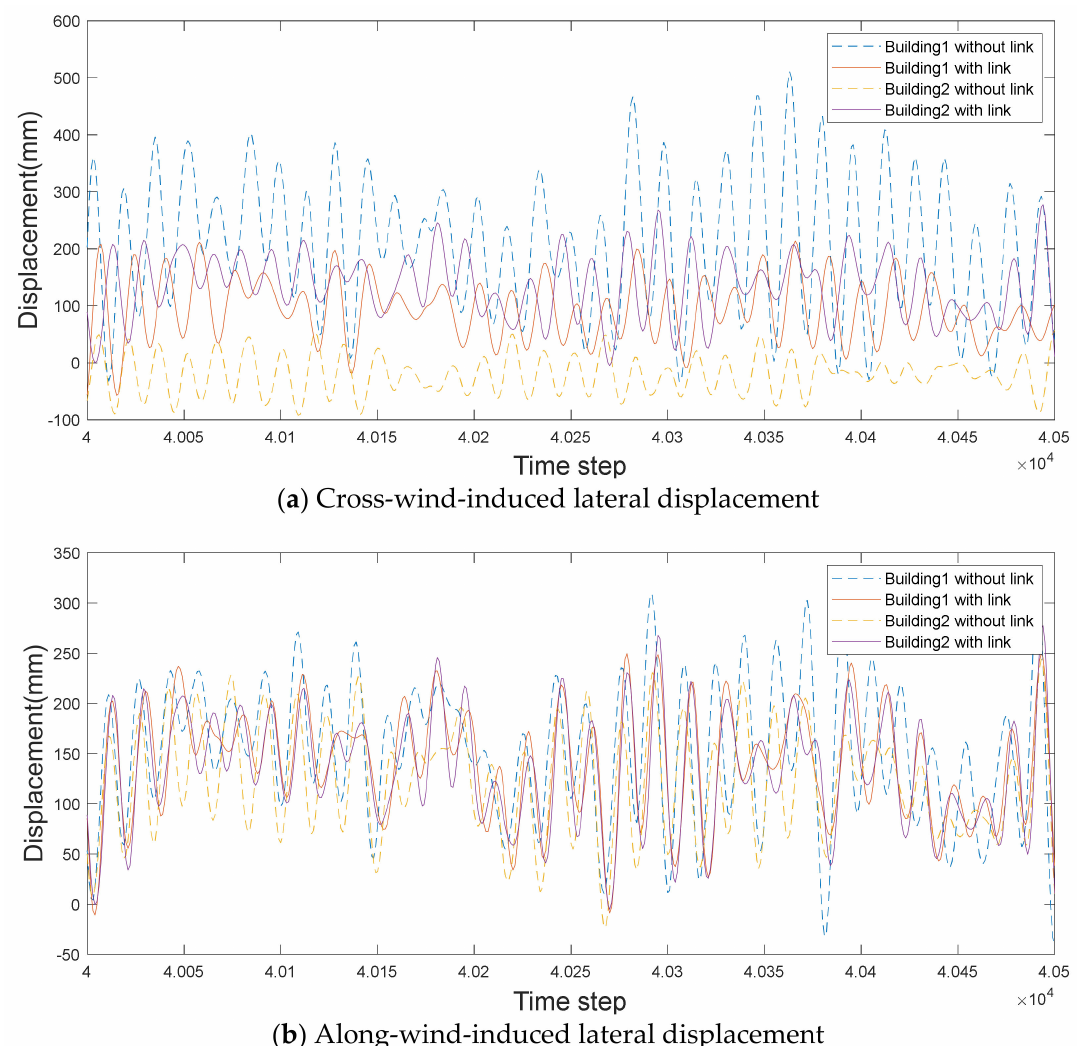
Figure 19. Time histories of wind-induced response with a small gap distance. When there is no link with a large gap distance, the aerodynamic characteristics (pressure distribution and wind-force coefficients) of the two buildings are similar, as lateral displacements. Even when there is a link, the lateral displacements of the two smaller than the reduction in the cross-wind lateral displacement with a small gap distance.